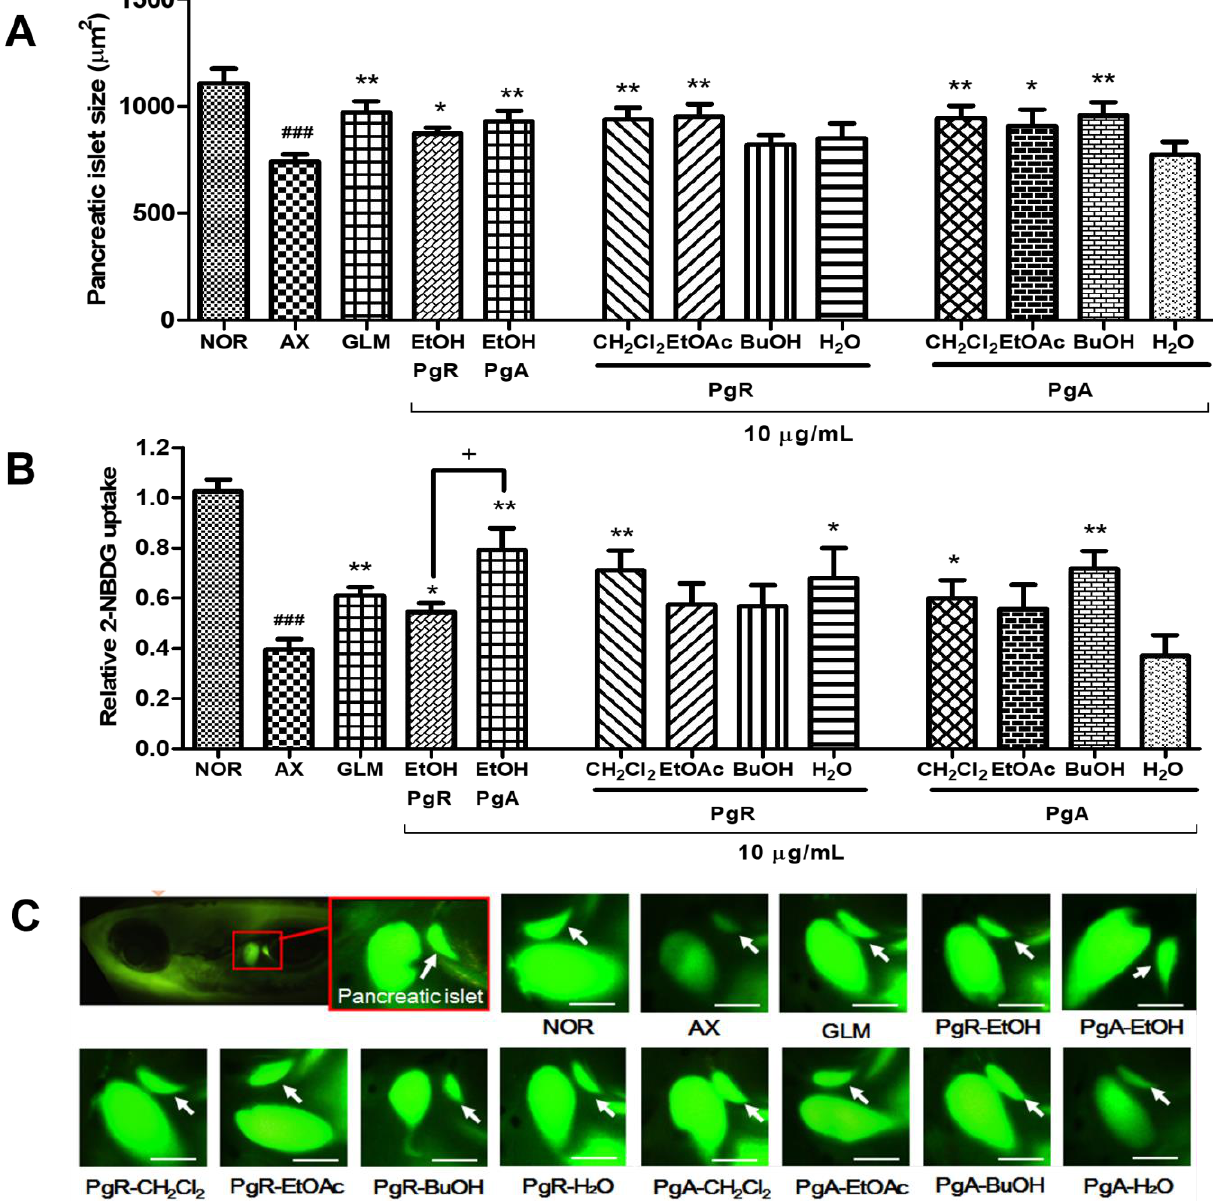
Figure 2. Effect of extracts and solvent fractions from the aerial part and root of P. grandiflorus on an alloxan-induced diabetic zebrafish. ( A ) Change in pancreatic islet size caused by GLM, PgR-EtOH and PgA-EtOH extracts (10 μg/mL) and their solvent fractions (10 μg/mL); ( B ) relative 2-NBDG uptake in pancreatic islet caused by GLM, PgR-EtOH and PgA-EtOH extracts and their solvent fractions; ( C ) fluorescent microscopic images of the pancreatic islet (### p < 0.001; compared to NOR) (* p < 0.05, ** p < 0.01; compared to AX) (+ p < 0.05). Scale bar = 100 μm.